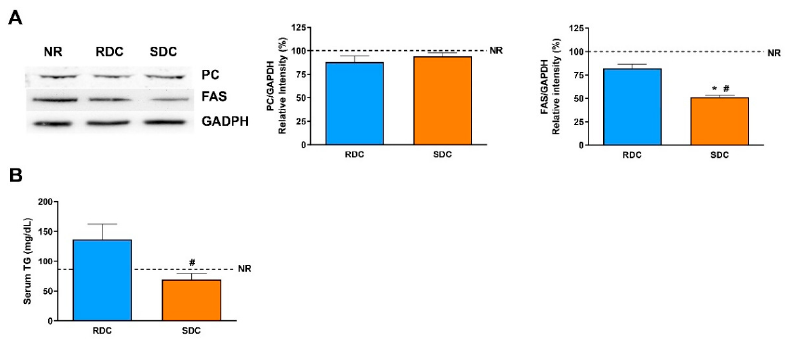
Figure 9 . Lipogenesis in liver of the different experimental groups. ( A ) The expression of two lipogenic enzymes were assayed by western blot. ( B ) Circulating triacylglycerols (TG) in fasting were measured. NR group, not restricted; RDC group, refeeding with rapid digestible CHO diet; SDC group, refeeding with slow digestible CHO diet. * Significant difference with NR group, p < 0.05. # Significant difference with RDC group, p < 0.05.